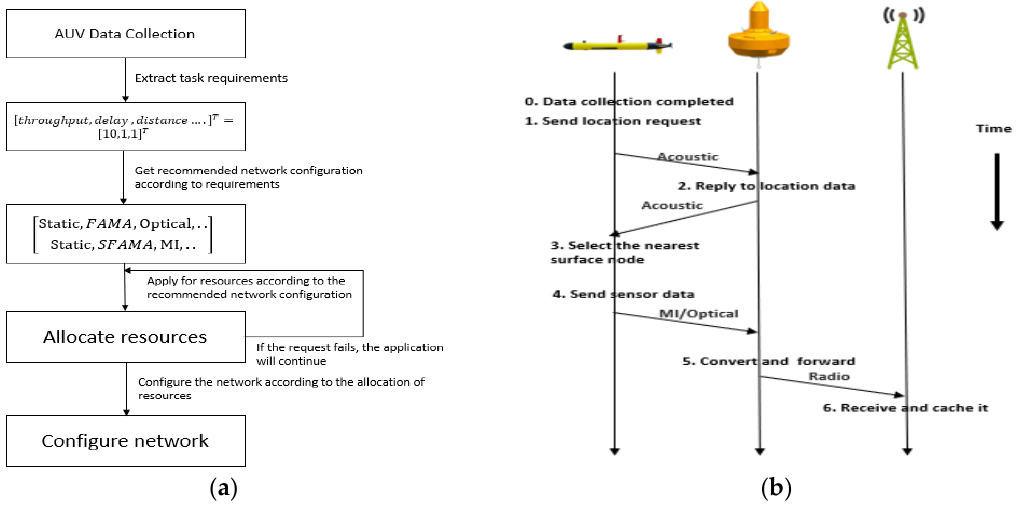
Figure 16. ( a ) Data collection application network resource request; ( b ) detailed information on the interaction between terminals of underwater data collection network.